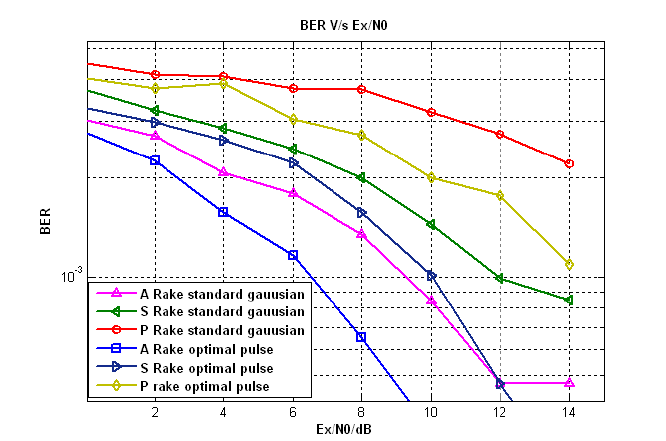
Fig.17. BER Comparison of optimal pulse and the standard Gaussian pulse.